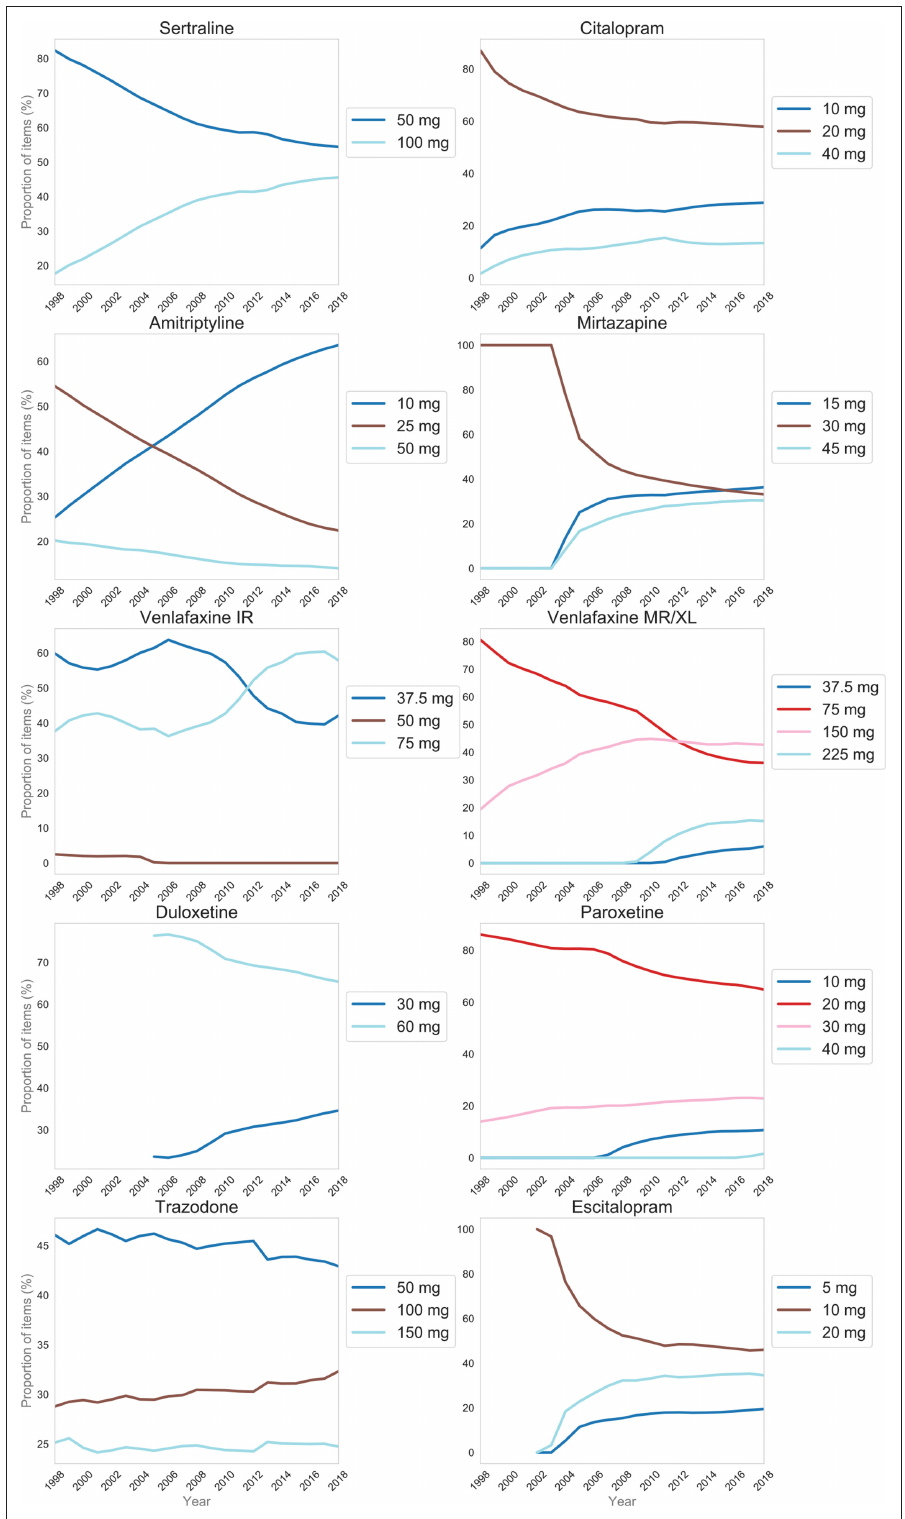
Figure 3 The proportions of specific antidepressant drug strengths prescribed by drug, for the 10 most commonly prescribed antidepressants (in 2018), from 1998–2018. Fluoxetine data not shown. IR = immediate release. MR